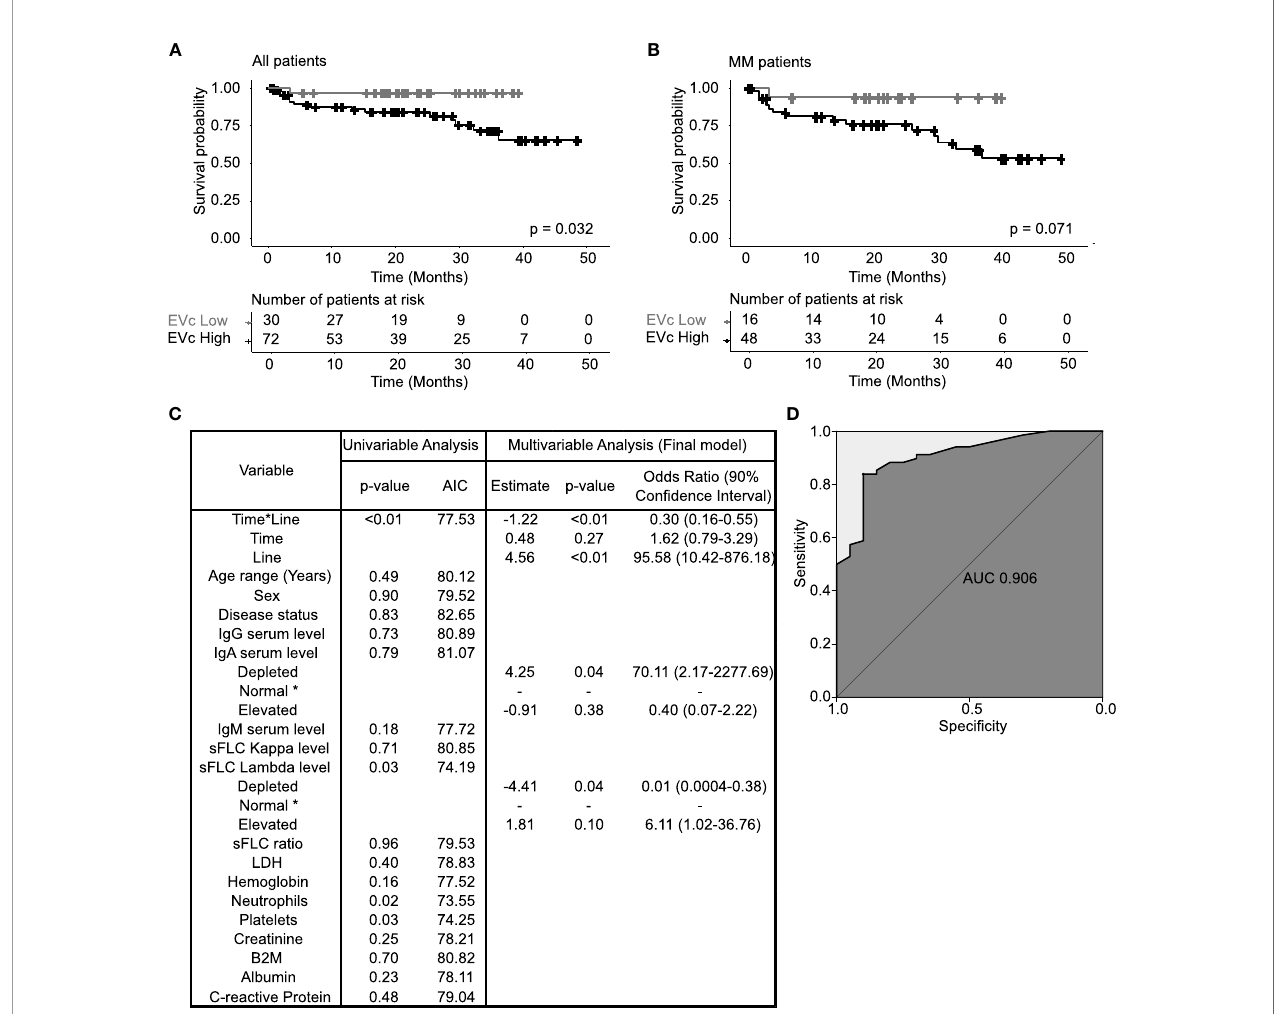
FIGURE 3 | Extracellular vesicle cargo (EVc) characterization in terms of patients ’ survival and longitudinal assessment. EVc, or protein-to-particle ratio, was de fi ned by the ratio between the EV protein concentration and the EV particle concentration, for each EV sample. (A) Kaplan – Meier curves of patients ’ overall survival (OS) according to the EVc level and diagnostic category. Applying the same method for optimal cut-off assessment as used for EV protein and particle concentration, MG patients (MGUS, SMM, and MM) with high EVc (>0.6 µg/10 8 EV) had a statistically signi fi cant lower OS when compared to patients with low EVc ( ≤ 0.6 µg/10 8 EV; log-rank test, p-value=0.032). (B) Comparing the speci fi c EVc levels for MM (with SMM) patients, one can state that EVc High (>0.6 µg/10 8 particles) patients always present a worse prognosis than EVc Low ( ≤ 0.6 µg/10 8 particles) (considering a signi fi cance level of 10%: log-rank test, p-value=0.071). (C) Description of the variables tested to predict the odds of patients having a high EV cargo over time (SMM, MM-ND, MM-NR, and MM-R patients). Patient laboratory parameters obtained between 30 days before and 1 week after EV collection were used. Time — the chronological sequence of sample collection in each patient; line — the number of previous treatment lines. A variable of the interactions between time and line variables ( time*line ) was used to infer time in response (number of samples collected within the same line of treatment). The fi nal model (multivariable analysis) resulted from a stepwise selection procedure, where variables were added one at a time and singularly tested in a univariable model. Wald test was used as a method for parameter signi fi cance testing. Model selection was performed through likelihood ratio test (LRT) computation, considering an inclusion/exclusion p-value set at 0.2 as described by Bendel and A fifi (17). IgA serum level, sFLC lambda level, and time*line were signi fi cant in the fi nal model (p<0.1). (D) Final model goodness-of- fi t graphical representation by the receiver operating characteristic (ROC) curve with an area under the curve (AUC) of 0.906. AIC (Akaike information criterion); * (reference class). sFLC, serum free light chain; B2M, b 2 microglobulin;